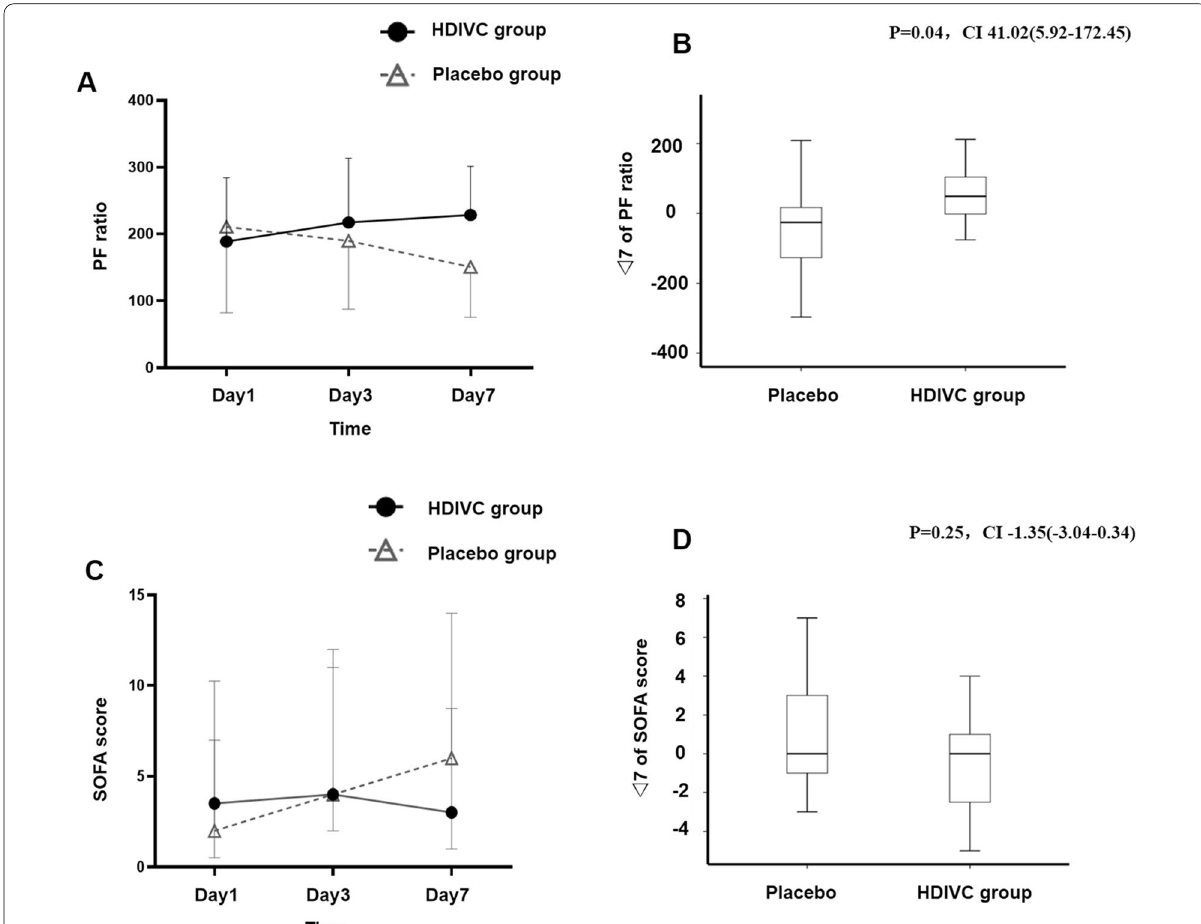
Fig. 4 P/F and SOFA scores following high-dose intravenous vitamin C treatment. a The bars show the standard deviation (SD) of the mean. The P/F in both groups was approximately 200 at enrollment. After initiation of treatment, there was a steady rise in the P/F in the HDIVC group and a decline in the P/F in the placebo group (day 3: 217 vs. 189, 95% CI -34 to 90, P means the difference between the value from Day1 to Day7. Boxes represent the median and interquartile range (25th and 75th percentiles), and whiskers represent the range of values. The delta P/F ratio showed a different result in two groups (20.0 (5.92–172.45)). △ 7 was calculated by the difference between the value from Day 1 to Day 7. c The bars showed the interquartile range (IQR) of the median. There was no difference in the initial Sequential Organ Failure Assessment (SOFA) scores of the 2 groups at baseline (vitamin C vs placebo, median, 3.5[3.0–6.8] vs 2.0 [3.0–5.0]). After 7-day treatment, the median of SOFA score increased from 2.0 to 6.0 in the placebo group and slightly decreased from 3.5 to 3.0 in the HDIVC group, but there was no difference between the 2 groups. d △ 7 of SOFA scores means the difference between the value from Day1 to Day7. Boxes represent the median and interquartile range (25th and 75th percentiles), and whiskers represent the range of values. The delta SOFA scores showed no significant difference in two groups (0.0[-2.75-1.0] vs. 0.0[-1.0-3.5], P △ 7 was calculated by the difference between the value from Day 1 to Day 7. HDIVC high-dose intravenous vitamin C, SOFA Sequential Organ Failure Assessment, P/F